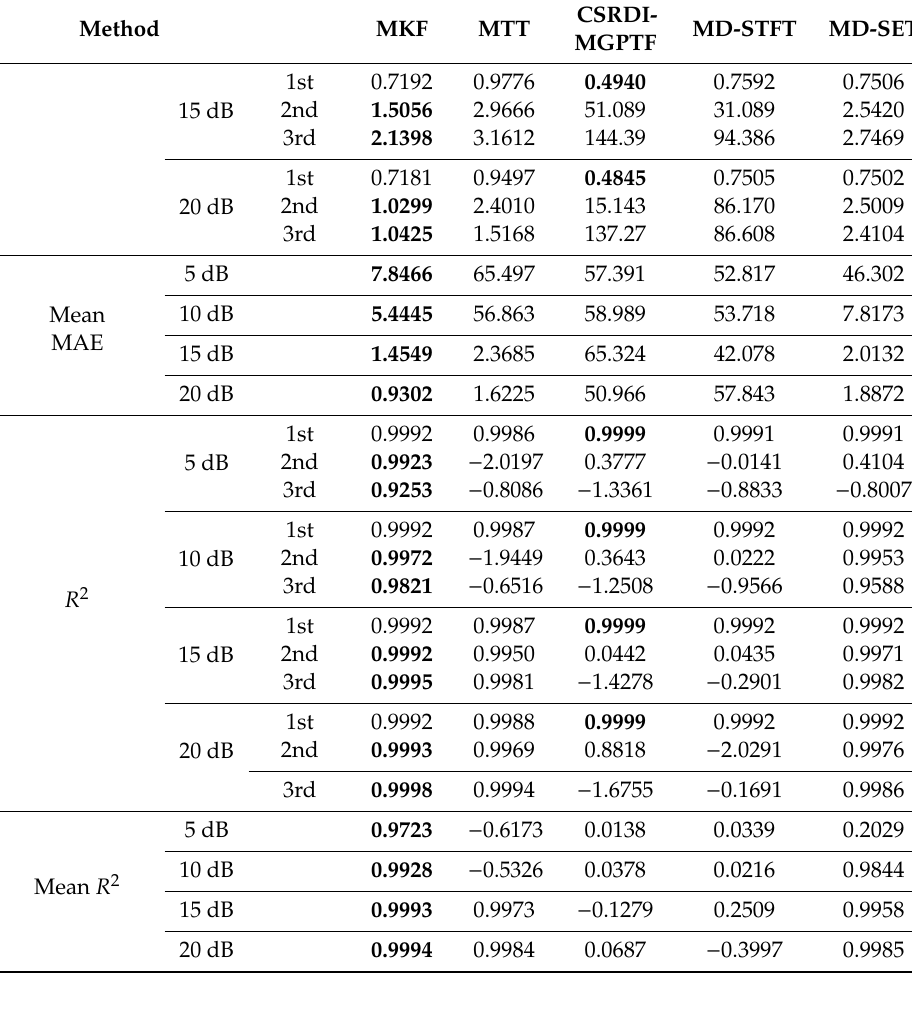
Figure 12. The values of diagonal elements of covariance matrix i